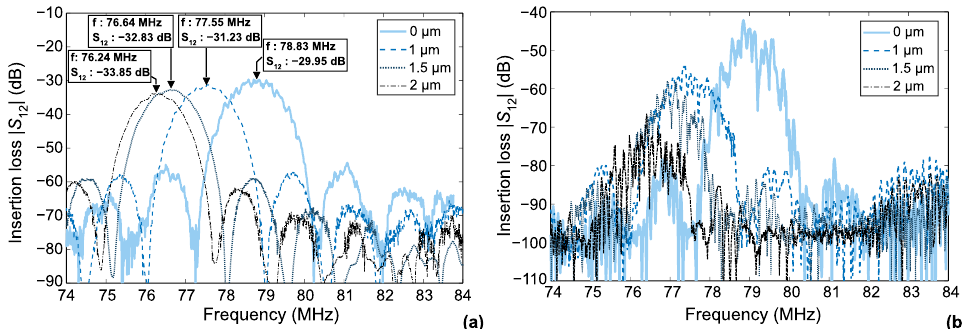
Figure 2. S 12 measurements: ( a ) between opposite IDTs of the same channel (IDT 11 and IDT 12 in Figure 1); ( b ) opposite IDTs belonging to adjacent sensor channels (‘IDT 11 ’ and ‘IDT 22 ’ in Figure